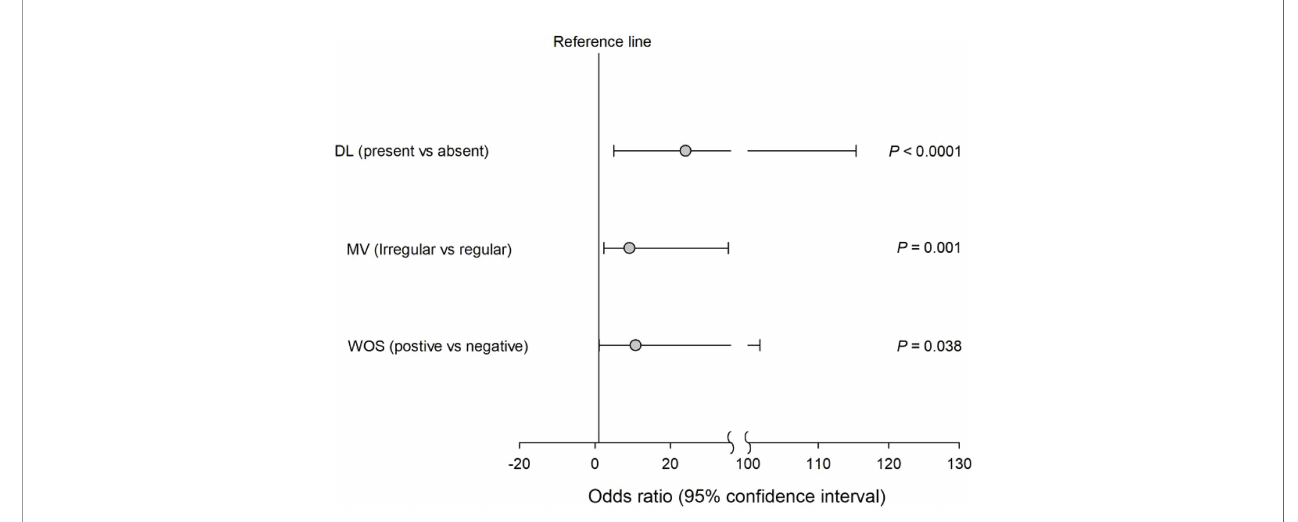
FIGURE 1 | Univariate logistic regression analyses revealed that the presence of DL irregularity of MV and the presence of WOS were signi fi cantly associated with the risk of the upgraded group in patients with NBI